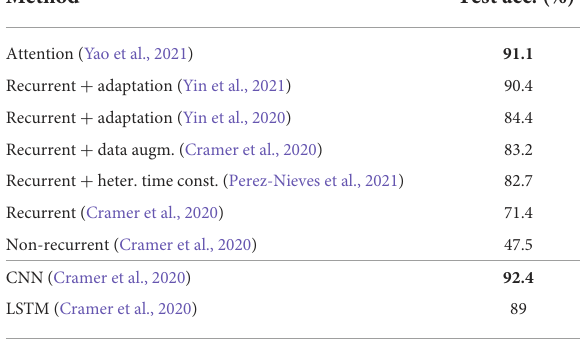
TABLE 2 State-of-the-art on the SHD dataset. Method